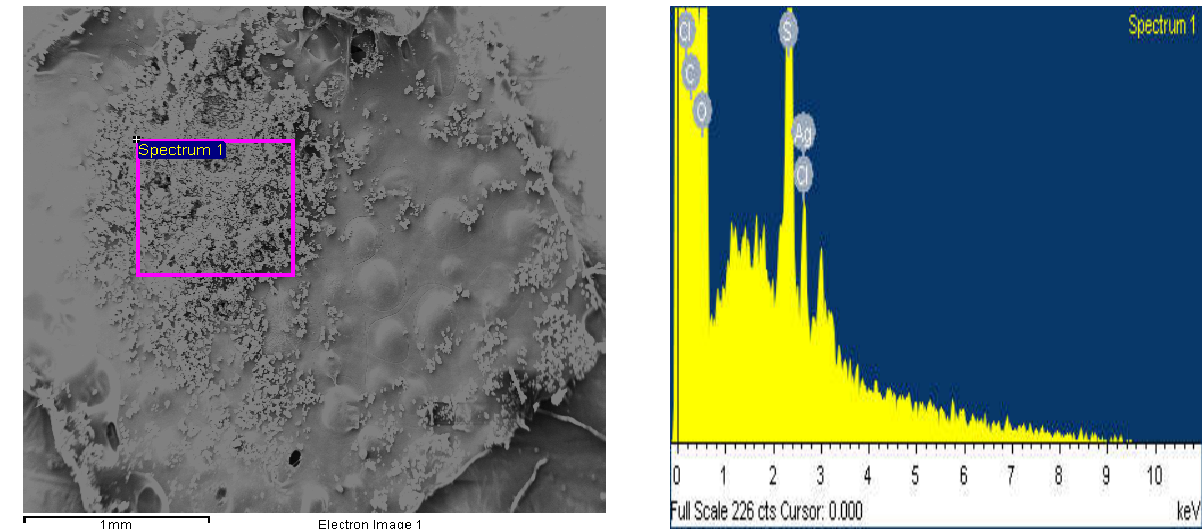
Figure 5. EDAX images of the PANI-Ag composite.